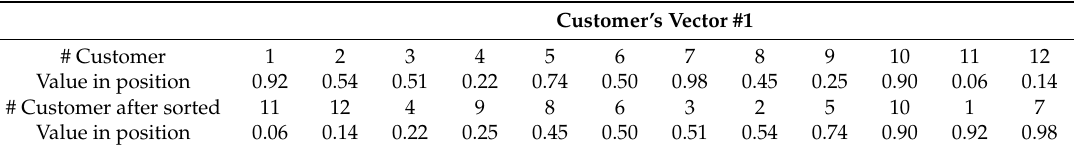
Table 9. Results of the calculation of cumulative visiting